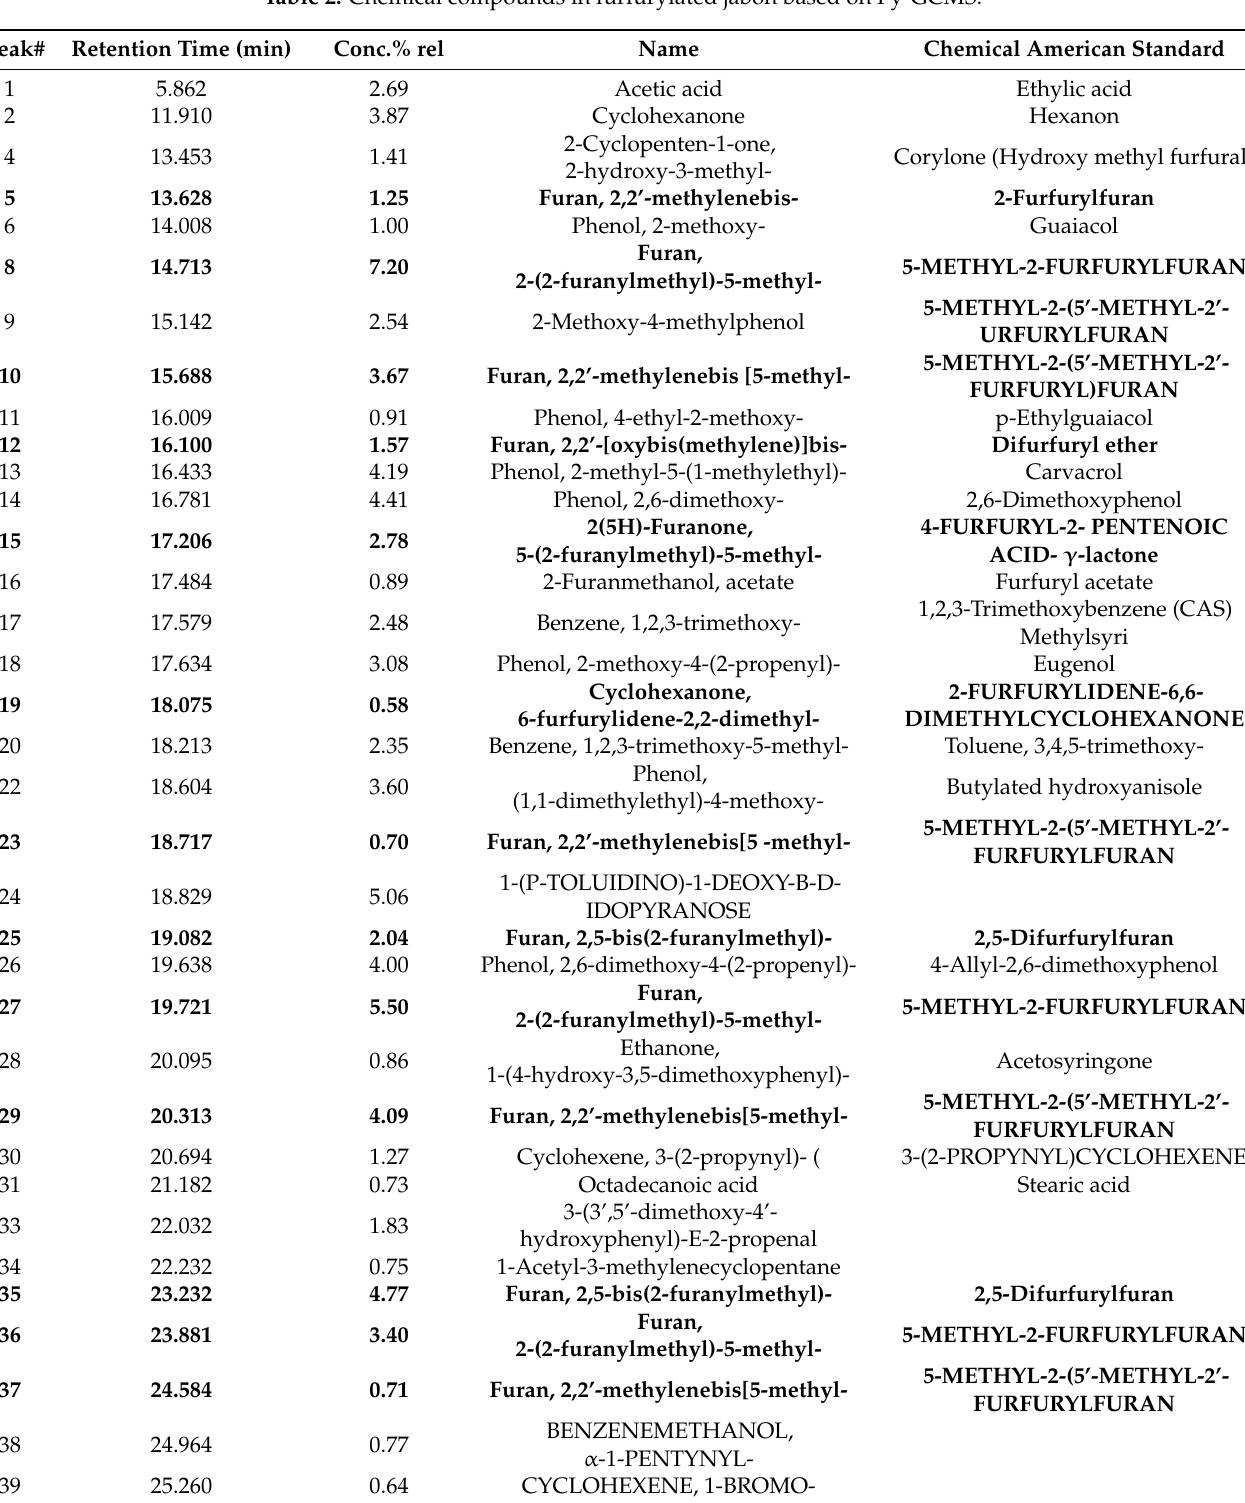
Table 2. Chemical compounds in furfurylated jabon based on